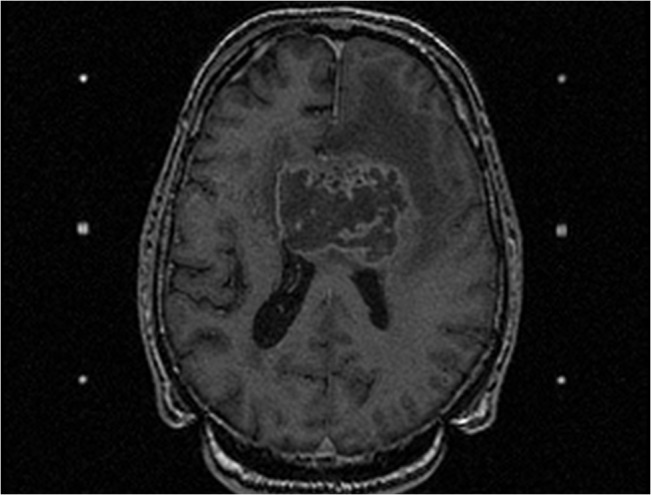
MRI performed for a seventy-three-year-old man presented to the emergency department with bilateral muscular weakness members, cognitive disorders and KPS of 60.The T1W sequence with gadolinium injection showed a large bifrontal GBM invading the corpus callosum. Stereotactic biopsy revealed the presence of a glioblastoma multiforme (confirmed by independent reviewing). This patient had almost all factors of poor prognosis (sex, age, low KPS, tumor localization, no surgical treatment) but received concomittant radiochemotherapy with temozolomide and survived 4 years.